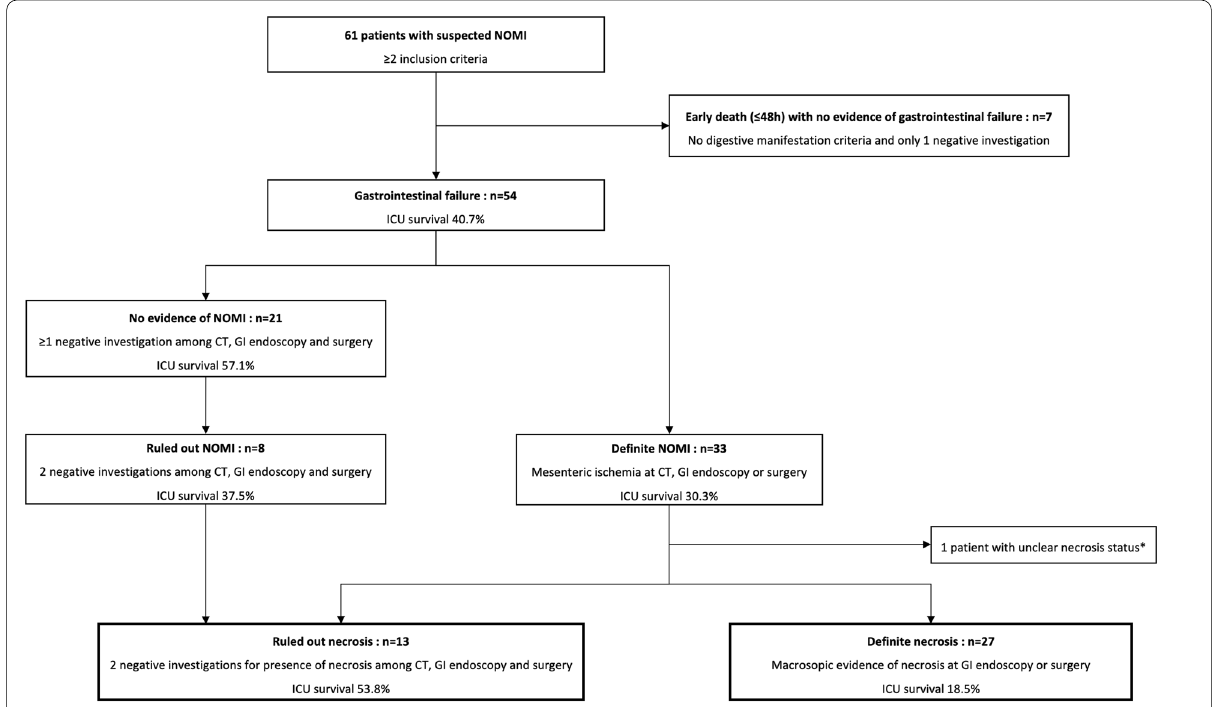
Fig. 1 Flowchart of patients’ classification according to the presence or absence of NOMI and